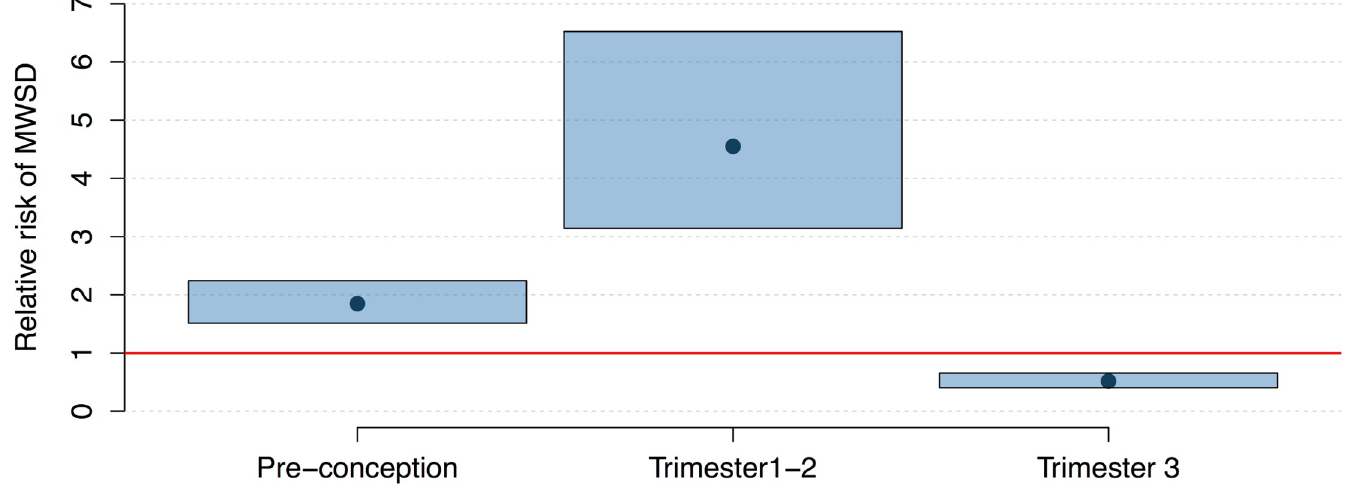
Fig 3. Relative risk of microcephaly with structural brain defects (MWSD) given Zika virus infection at different times in pregnancy. Black dots and blue bars represent the mean and 95% confidence intervals, respectively, of the estimated microcephaly relative risk for women exposed to median Zika virus incidence levels at different times in pregnancy. The red line shows a relative risk of 1 (i.e., no risk).